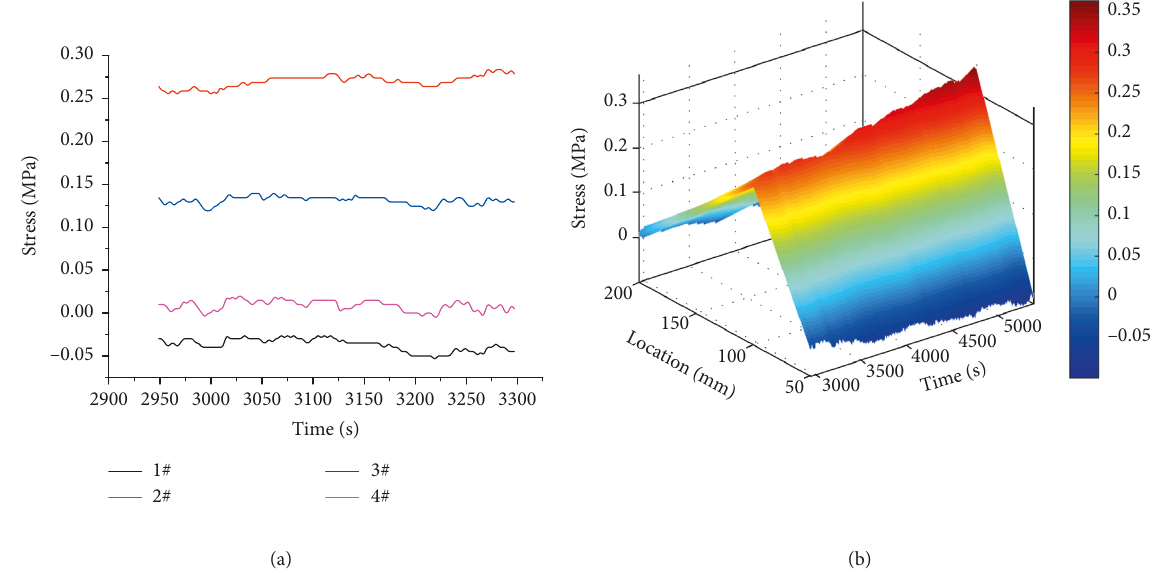
Figure 5: Stress evolution during the first excavation in the second stage: (a) the stress-time curve of 4 measuring points; (b) diagram of stress distribution at different locations over